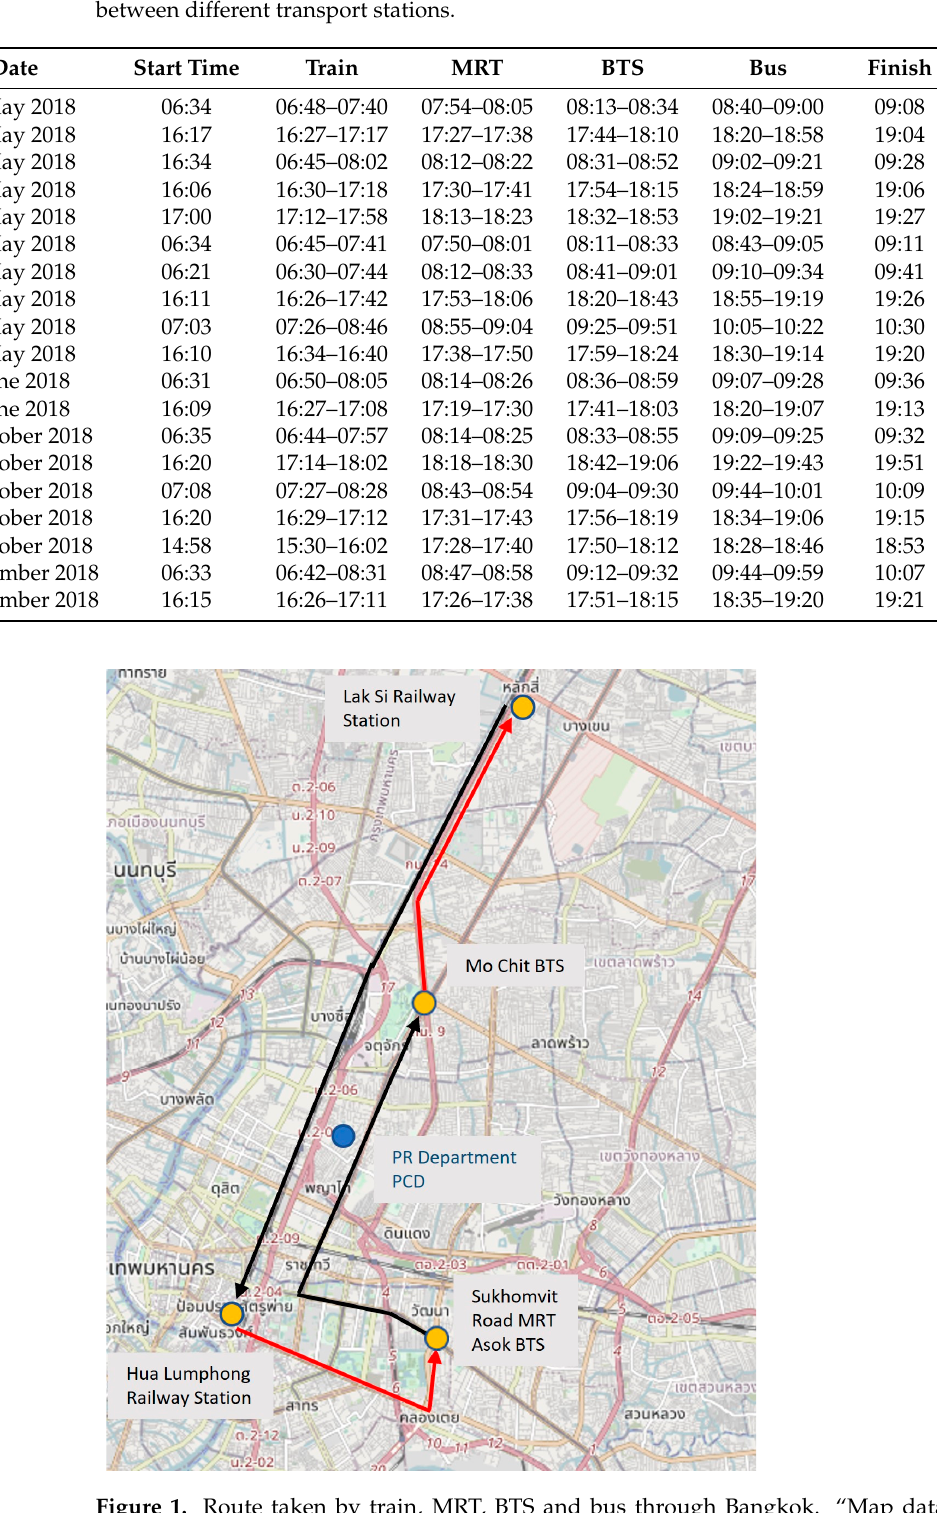
Figure 1. Route taken by train, MRT, BTS and bus through Bangkok. “Map data copyrighted